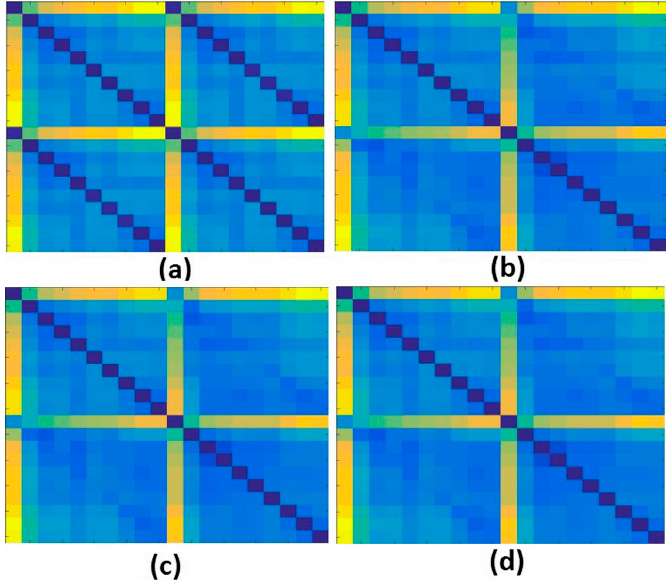
Figure 11. Set of frames formed from the EMI signatures for PZT#2: ( a ) baseline with Healthy (H); ( b ) baseline with damage 1 (D1); ( c ) baseline with damage 2 (D2); ( d ) baseline with damage 3 (D3).